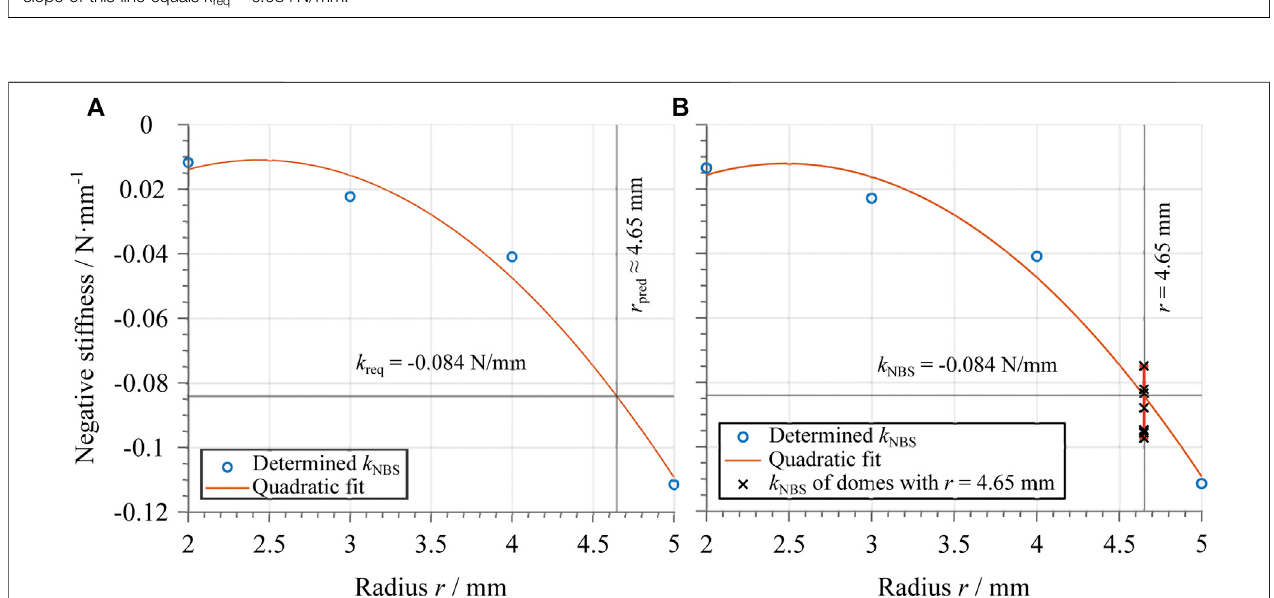
FIGURE8|(A) Dependencyofthenegativestiffnessofthedomeaveragecurvesonthe fl at-topradius.Thecirclesrepresentthedeterminedvaluesofthenegative slope k NBS , which are plotted against the corresponding value of the fl at-top radius r . The values are extracted from the graphs shown from Figure 6 , and are used to determineaquadratic fi t(redline).Thevalueofthepredicted fl at-topradius r pred iscalculatedbasedonthis fi t,byconsideringthevalueoftherequirednegativeslope k req reported in Figure 7 . (B) Dependency of the negative stiffness of the dome average curves on the fl at-top radius as in (A) together with the value of k NBS of eight individual optimal domes. The values of k NBS are shown with an errorbar, that states the deviation of the determined k NBS values.